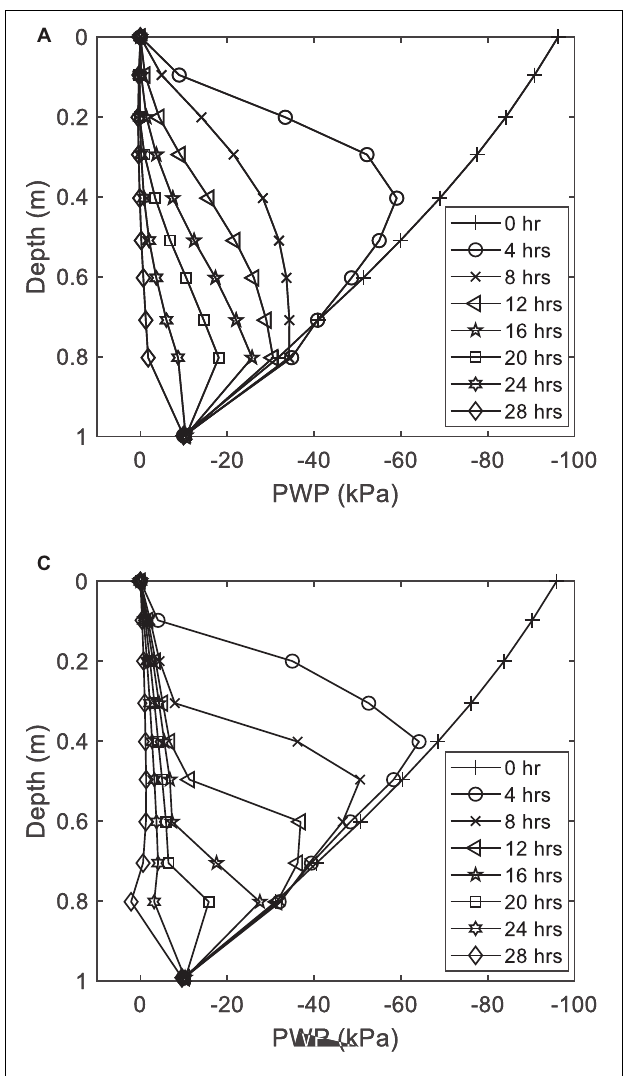
FIGURE 8 | The predicted variation of pore water pressure profiles with: (A) unimodal functions with k sat = 10 − 3 m/h; and (B) bimodal functions.